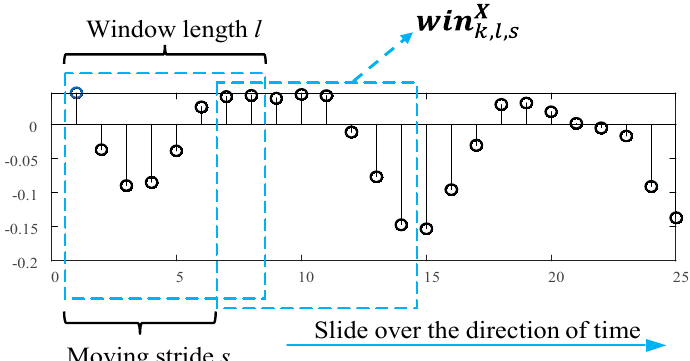
Figure 6. Illustration of the moving window 𝒘𝒊𝒏 (cid:3038),(cid:3039),(cid:3046)𝑿 .